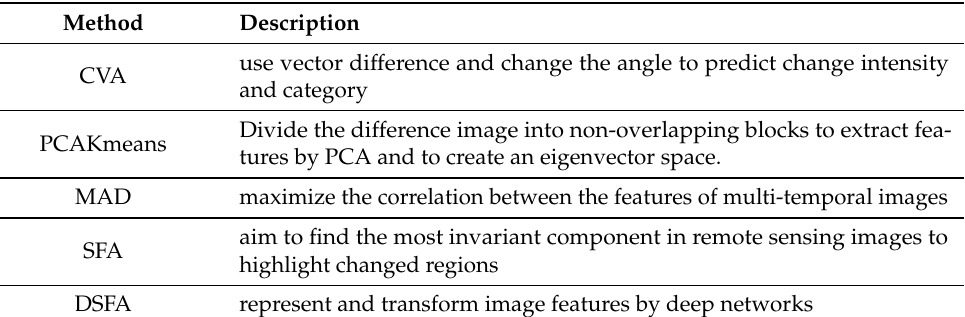
Figure 5. The example of four datasets.( a ) SZTAKI; ( b ) SYSU-CD; ( c ) LEVIR-CD; ( d ) ZMP-CD. Table 2. The description of the other unsupervised change detection